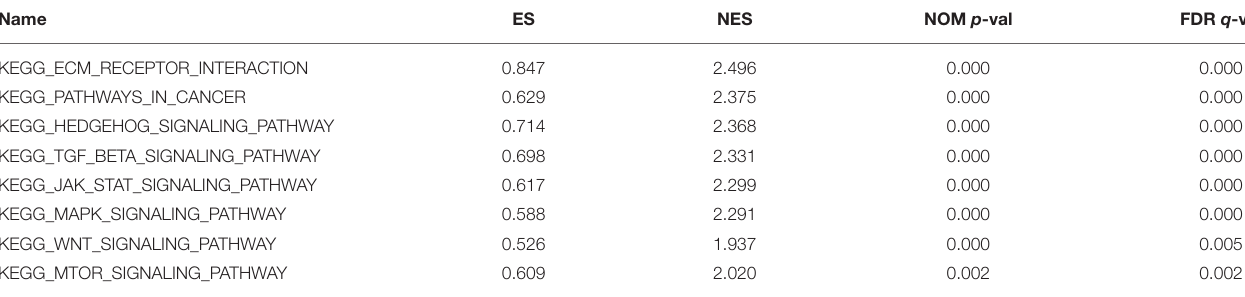
TABLE 4 | Gene sets enriched in the high LOX expression